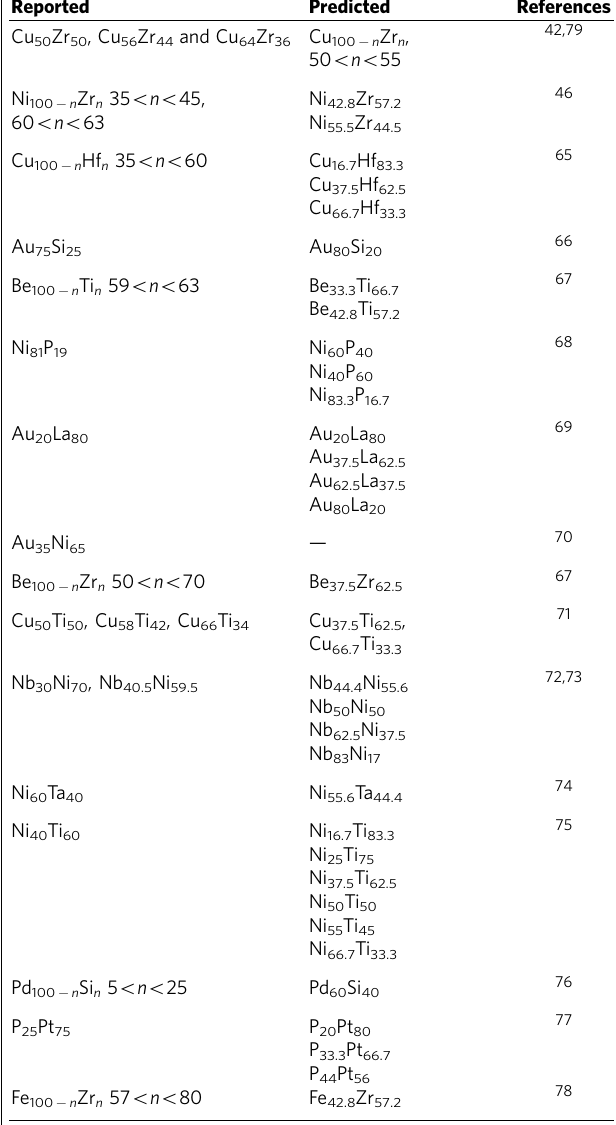
Table 1 | Experimentally reported glass formers.